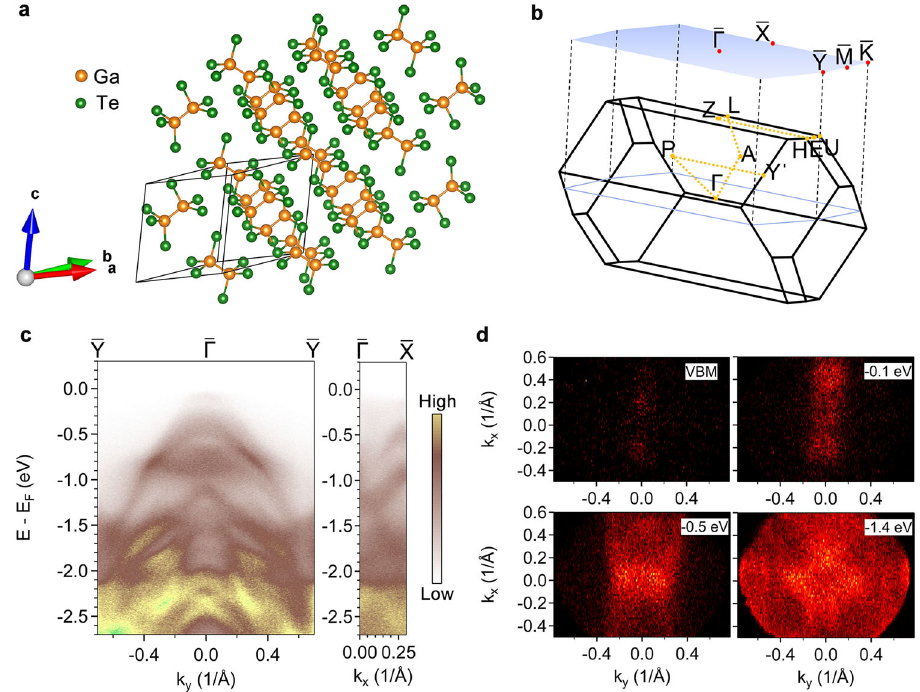
Fig. 1 Geometric and electronic structure of GaTe. a Crystal structure of bulk GaTe. The directions of the lattice vectors are indicated by ( a, b, c ). b First Brillouin zone (BZ) of bulk and surface GaTe. The high-symmetry points of bulk and surface BZ are marked by orange and red dots, respectively. The high symmetry path in the bulk BZ is plotted by orange dash line. c Valence bands near Fermi level along (cid:1) Γ - (cid:1) Y and (cid:1) Γ - (cid:1) X directions for GaTe obtained by angle- resolved photoemission spectroscopy (ARPES) using He I α line. The color bar represents the ARPES intensity. d Constant energy surfaces from valence band maximum to a binding energy of − 1.4 (cid:1) Γ (cid:1) (cid:1) Γ (cid:1) dispersion along - Y direction is stronger than that along - X